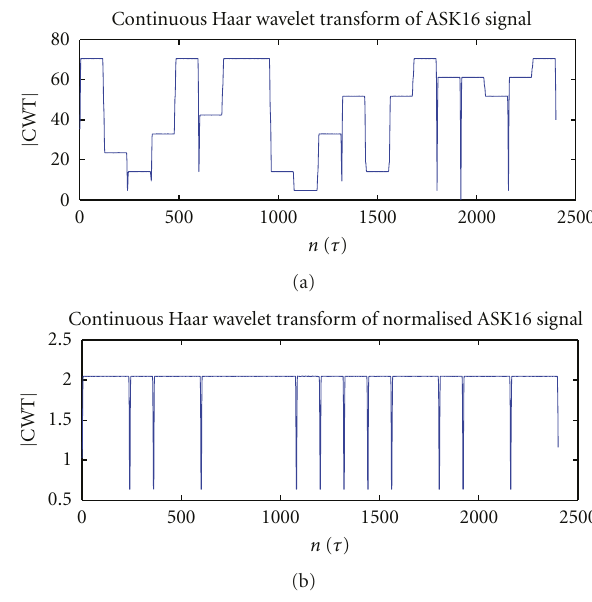
Figure 2: Multi-step wavelet transform of ASK16 signal and constant wavelet transform of its normalized